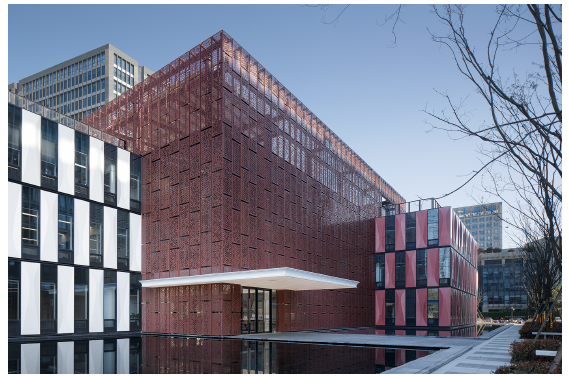
Figure 3. Real-life photograph of building